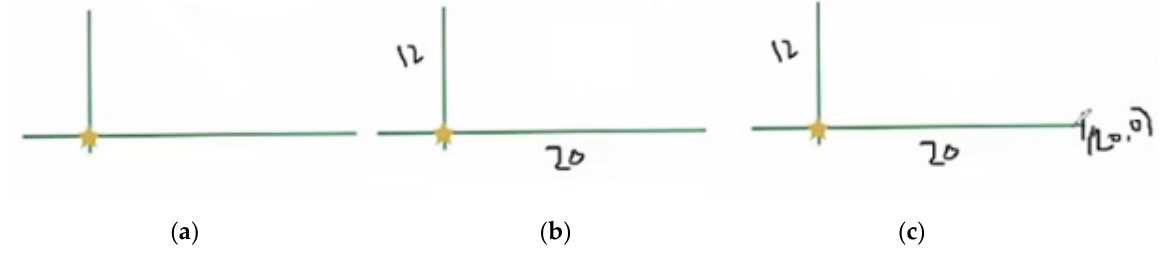
Figure 1. Point-to-point movement of a sprite in the positive X–Y plane. ( a ): draw a drawing that depicts the situation; ( b ): the sprite on (0,0); ( c ): the sprite move into (20,